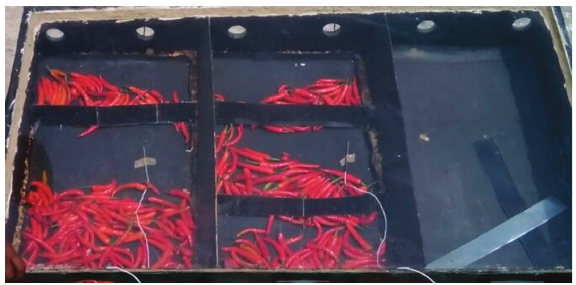
Figure 10: Red chillies in the solar